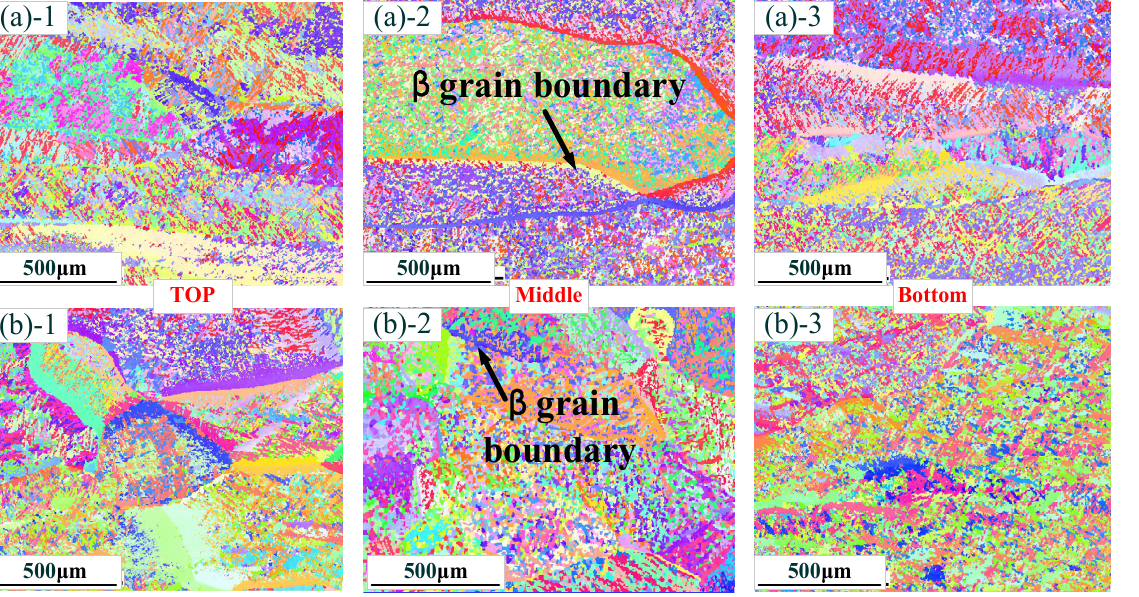
(b)-5 Figure 4. Distribution of the elements: ( a ) without La 2 O 3 ; ( b ) with La 2 O 3 . (Note: (a)-1–(a)-4 show the distribution of the elements with Ti-Al-V, Ti, Al and V; (b)-1–(b)-5 show the distribution of the elements with Ti-Al-V, Ti, Al, V and La).